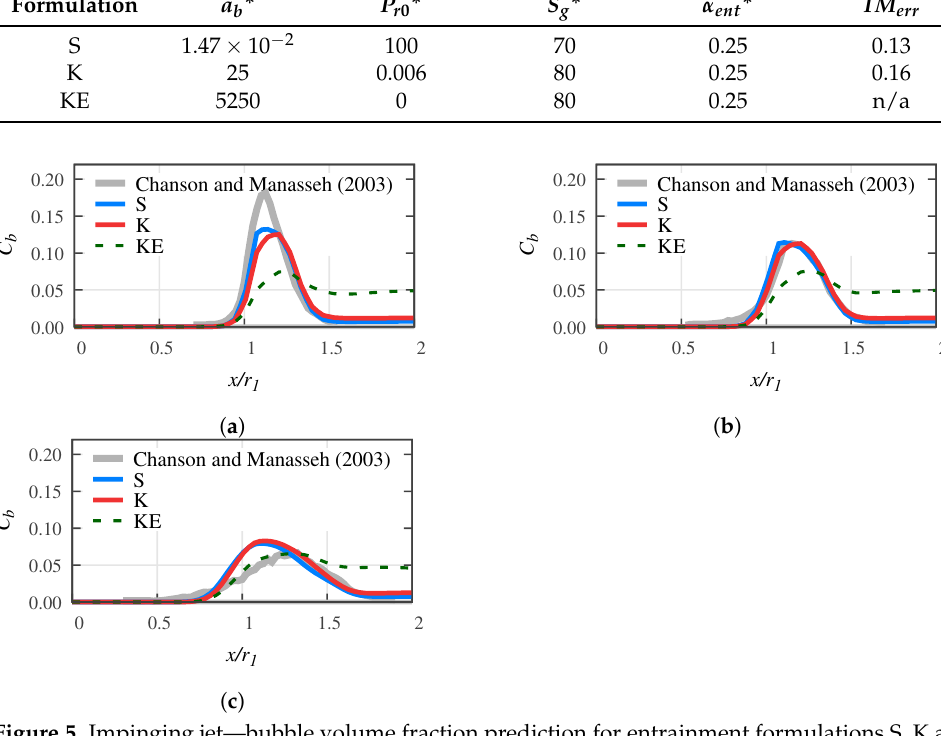
Table 2. Impinging jet—calibration of sub-grid models formulations: best parameter quadruplet. Formulation